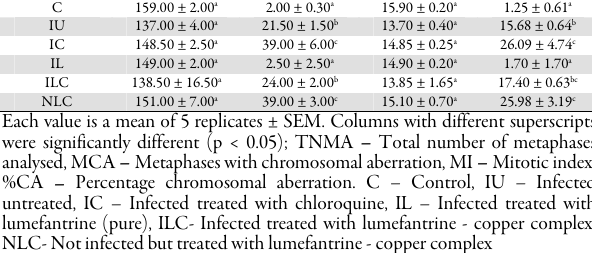
Table 9. Effect of lumefantrine and lumefantrine - copper complex on chromosomal aberration in the kidney of P. berghei NK-65 infected mice Groups